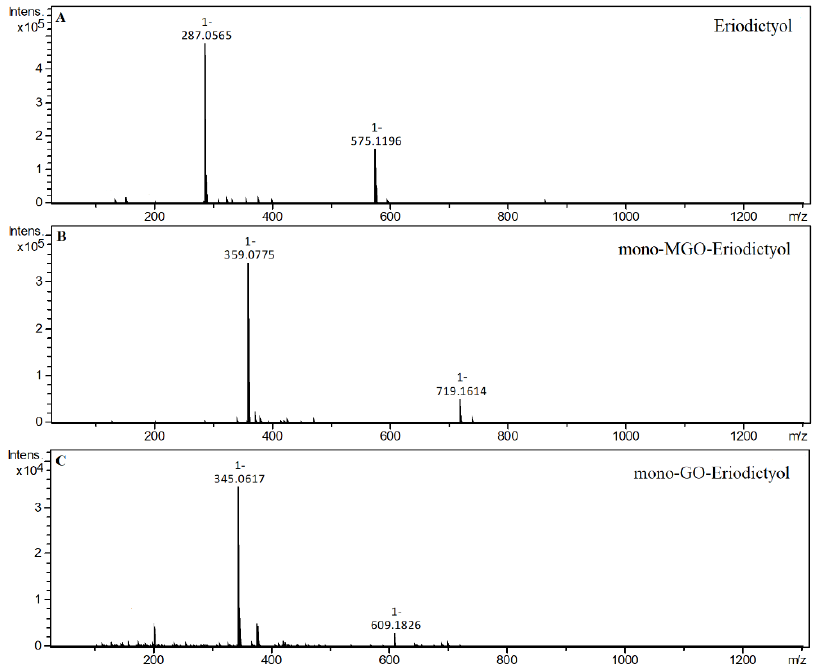
Figure 13. Mass spectra of eriodictyol and its methylglyoxal/glyoxal adducts after 1 h of incubation in pH 7.4 phosphate buffer solution at 37 °C; ( A ), eriodictyol; ( B ), mono-MGO-eriodictyol; ( C ), mono-GO-eriodictyol.